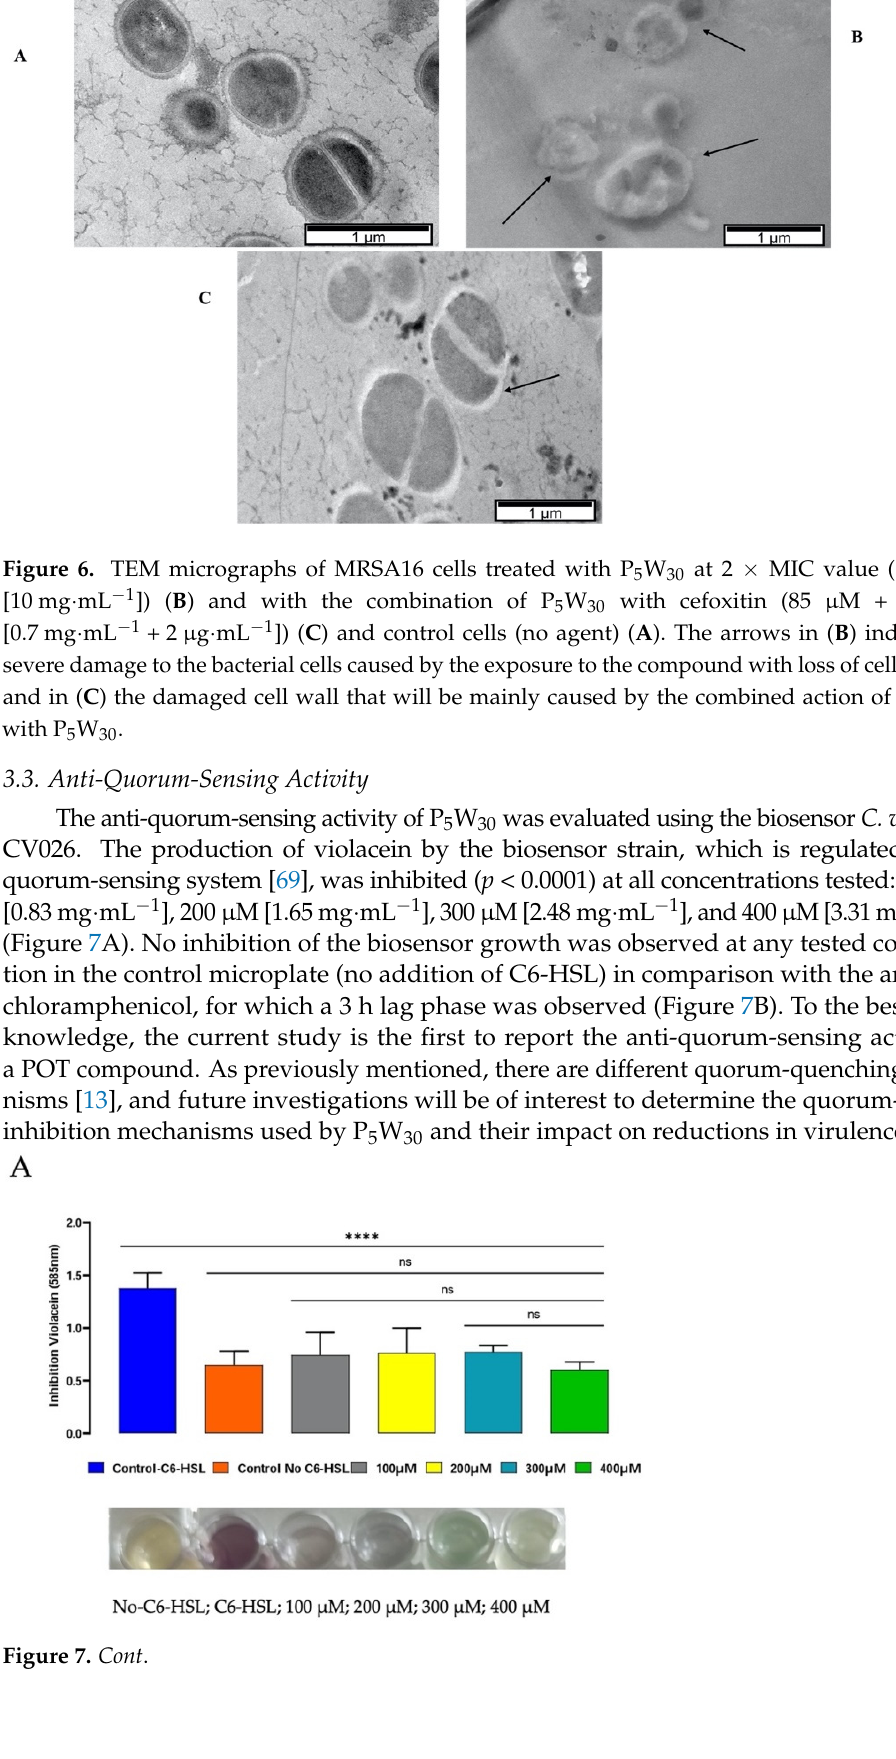
Figure 7. Anti-quorum-sensing activity of P 5 W 30 at concentrations 100 μ M (0.83 mg·mL − 1 ), 200 μ M (1.65 mg · mL − 1 ), 300 μ M (2.48 mg · mL − 1 ), and 400 μ M (3.31 mg · mL − 1 ). ( A ) Effect of P 5 W 30 on violacein production (OD 585nm ). ( B ) Effect of P 5 W 30 on C. violaceum CV026 growth. Error bars represent stand- ard deviation ( n = 3). **** p < 0.0001, ns—not significant. 3.4. Antibiofilm Activity For the evaluation of the antibiofilm properties, the MRSA16 cells were allowed to form biofilms in coverslips over 24 h, and afterwards, were treated for 6 h and 24 h with the compound P 5 W 30 at a concentration of 1211 μ M (10 mg·mL − 1 , 2 × MIC) and with the combination of P 5 W 30 with the antibiotic cefoxitin at concentrations of 85 μ M + 470 μ M (0.7 mg·mL − 1 + 2 μ g · mL − 1 ). The 2 × MIC value of P 5 W 30 and the combination of P 5 W 30 with the antibiotic was selected, taking into account the higher resistance of sessile cells that is not affected either by P 5 W 30 at the MIC value of or by the antibiotic cefoxitin at the MIC value. The results are represented in Figure 8. The disruption of the biofilm produced by